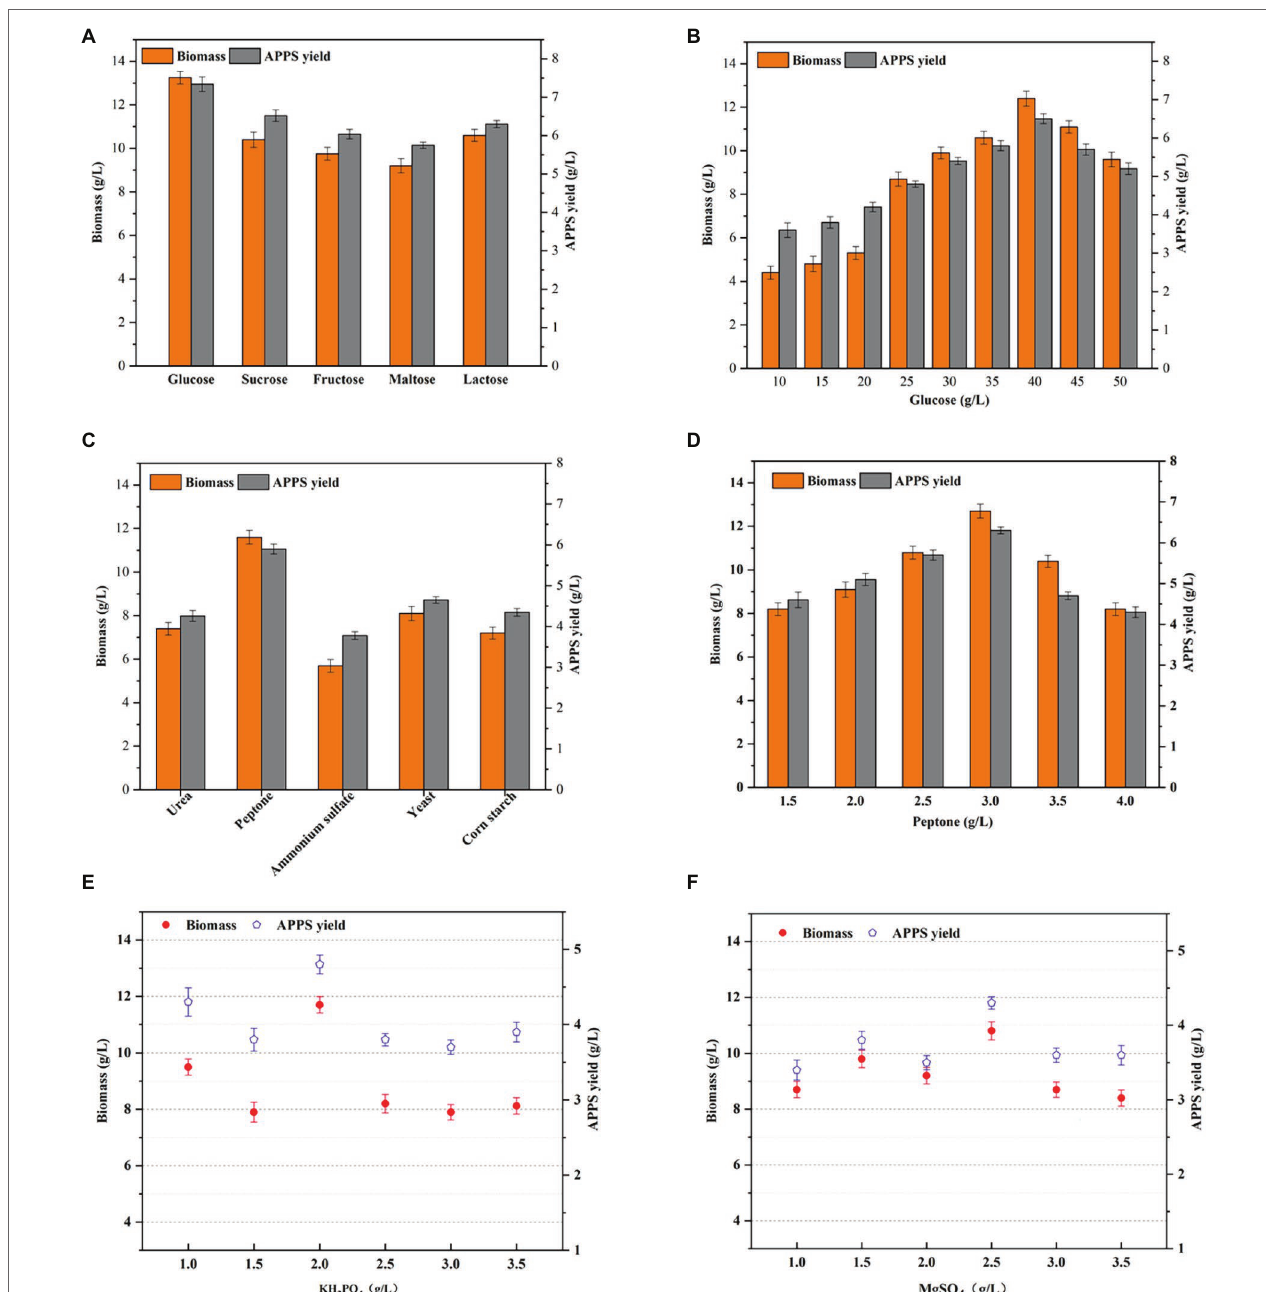
FIGURE 2 | Effects of different carbon sources and nitrogen sources and inorganic saltson APPS and biomass production by AP–10 fermentation and time distribution of yellow slurry water fermentation system. (A) . Optimization of fermentation carbon sources (pH 7, the nitrogen source was 3 g/L peptone, the inorganic saltson was a mixture of 2.5 g/L KH 2 PO 4 , and 1 g/L MgSO 4 for 3 days); (B) optimization of fermentation glucose concentration; (C) optimization of fermentation nitrogen sources (the carbon source was 40 g/L glucose); (D) optimization of fermentation peptone concentration; and (E,F) optimization of fermentation for the amount of inorganic saltson